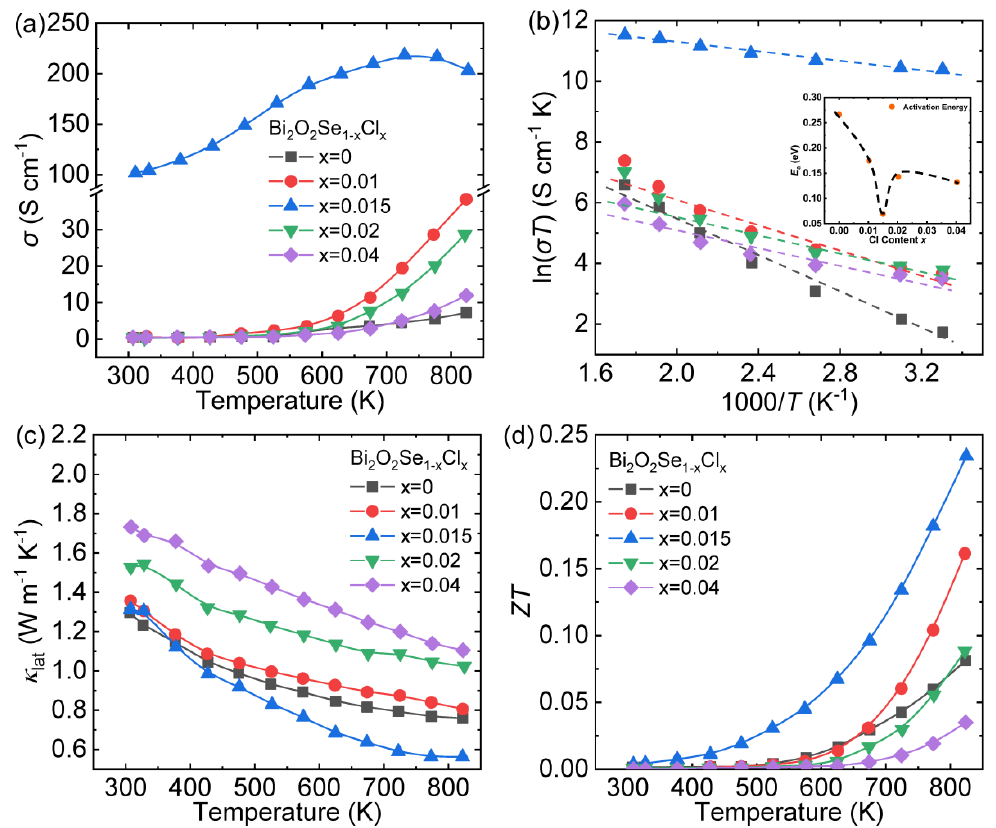
Figure 7. Thermoelectric transport properties of Bi 2 O 2 Se 1-x Cl x ( x = 0–0.04): ( a ) electrical conductivity, ( b ) the fitting plots of the small polaron model and the activation energy ( E a ) shown in the inset, ( c ) lattice thermal conductivity and ( d ) ZT . Data shown in ( a – d ) were adopted from Reference [51]. Copyright 2017, The American Ceramic